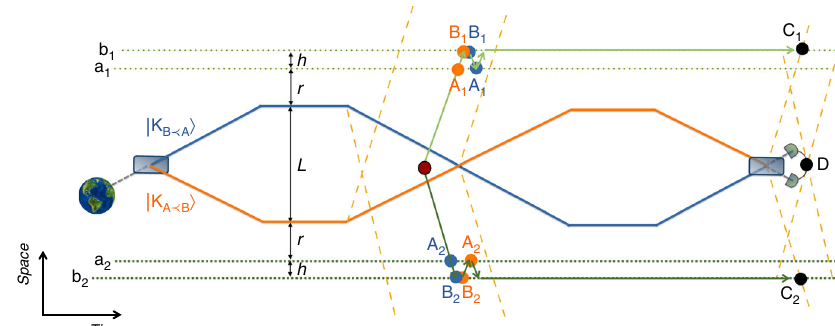
the mass is at a distance r + L from a 1 , and at r + A (cid:2) B